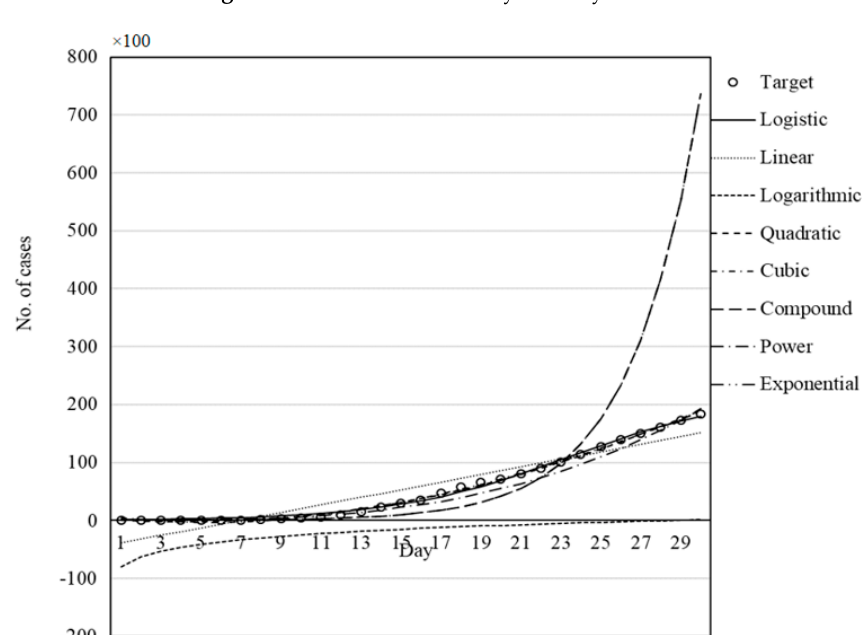
Figure 9. Set of models for Iran fitted by GWO.